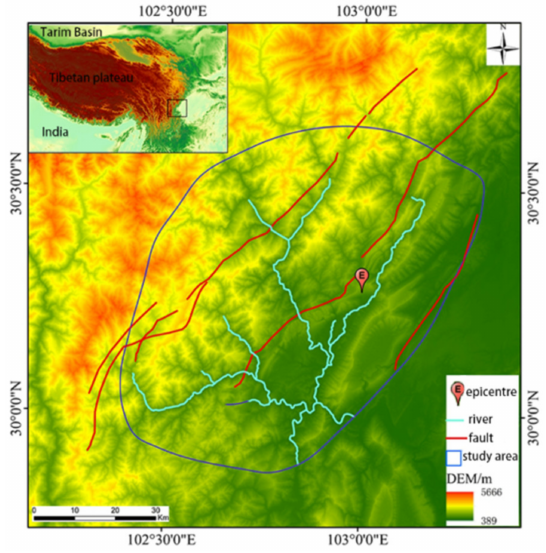
Figure 1. The geographical location of the study